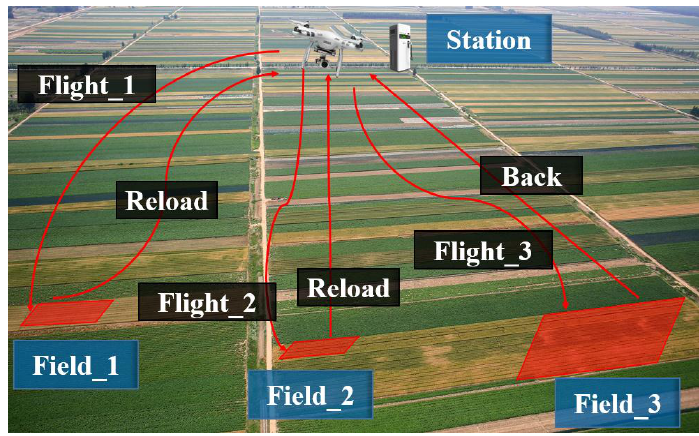
Figure 1. Mission example with single UAV.